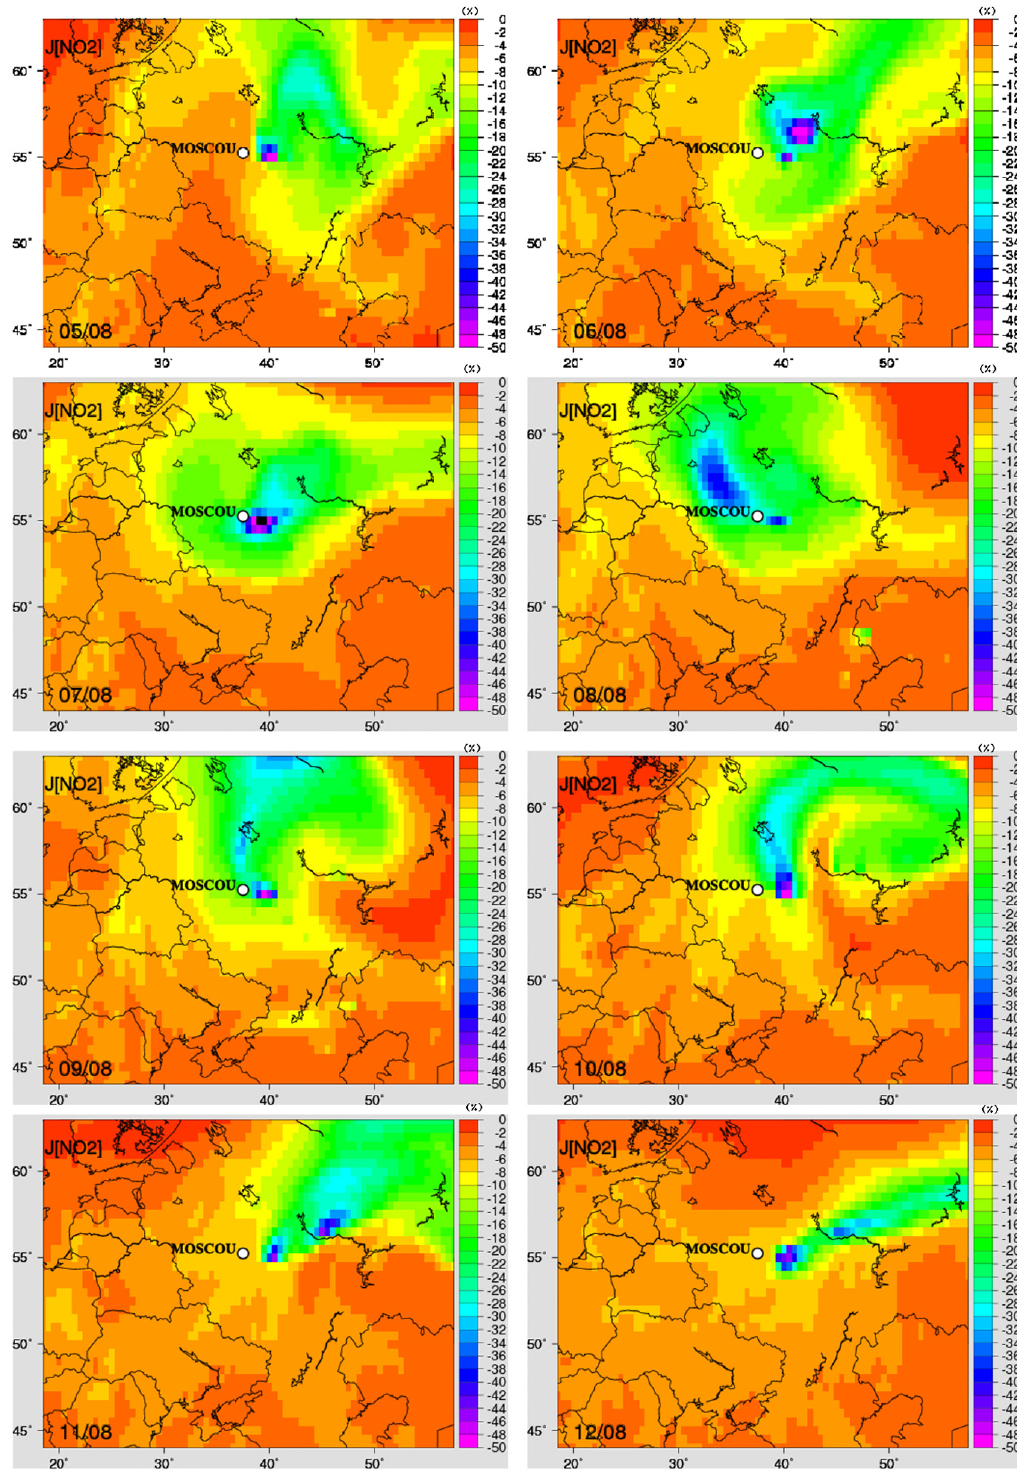
Figure 3. Geographic distribution of the modeled daytime average percentage changes in the near-surface J [NO 2 ] due to the presence of